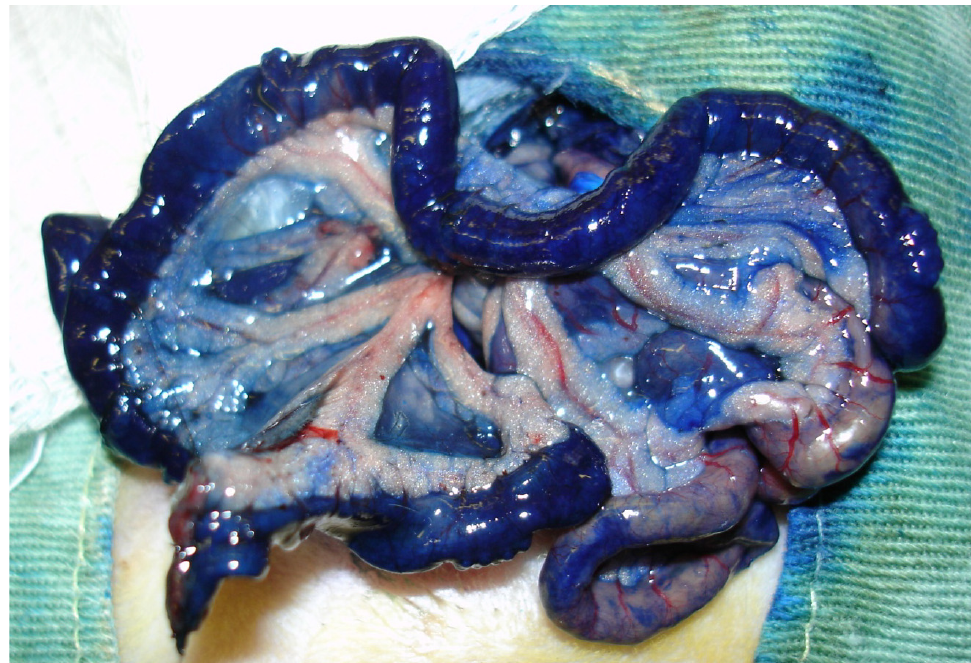
FIGURE 1 - Intestinal loops after injection of methylene blue and